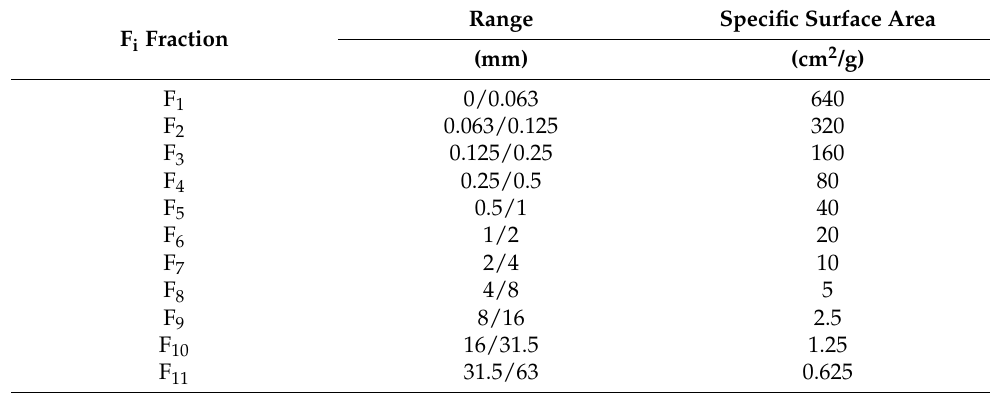
Table 2. The specific surface area of the pebble aggregate with the following density of 2.65 kg/dm 3.